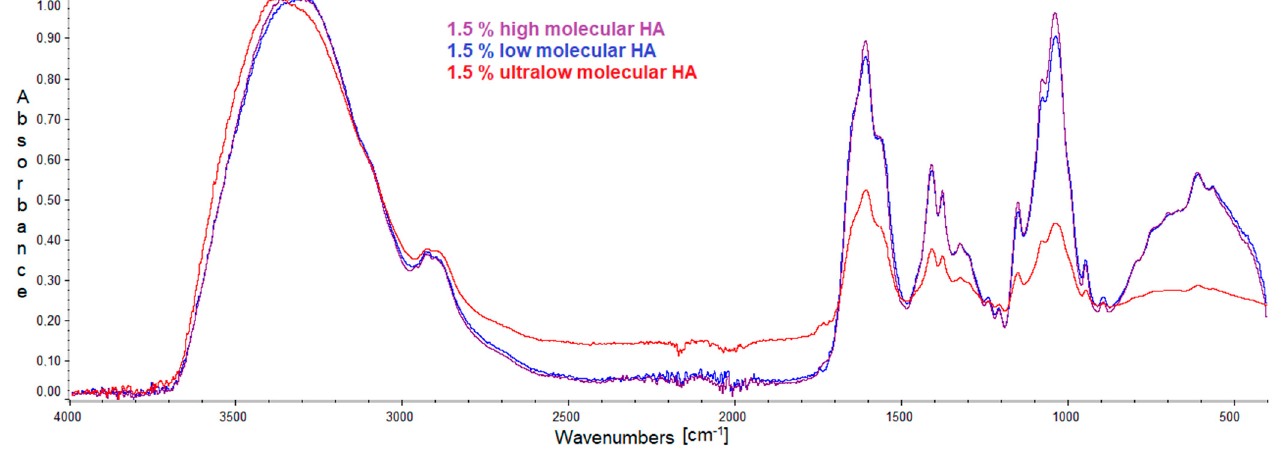
Figure 1. IR spectrum of high-, low-, and ultralow molecular weight hyaluronic acid.